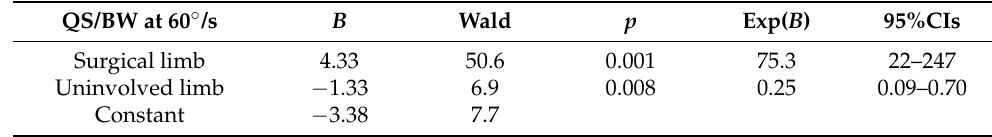
Table 6. Predictive model to return to running from isokinetic knee parameters. QS/BW at 60°/s B Wald